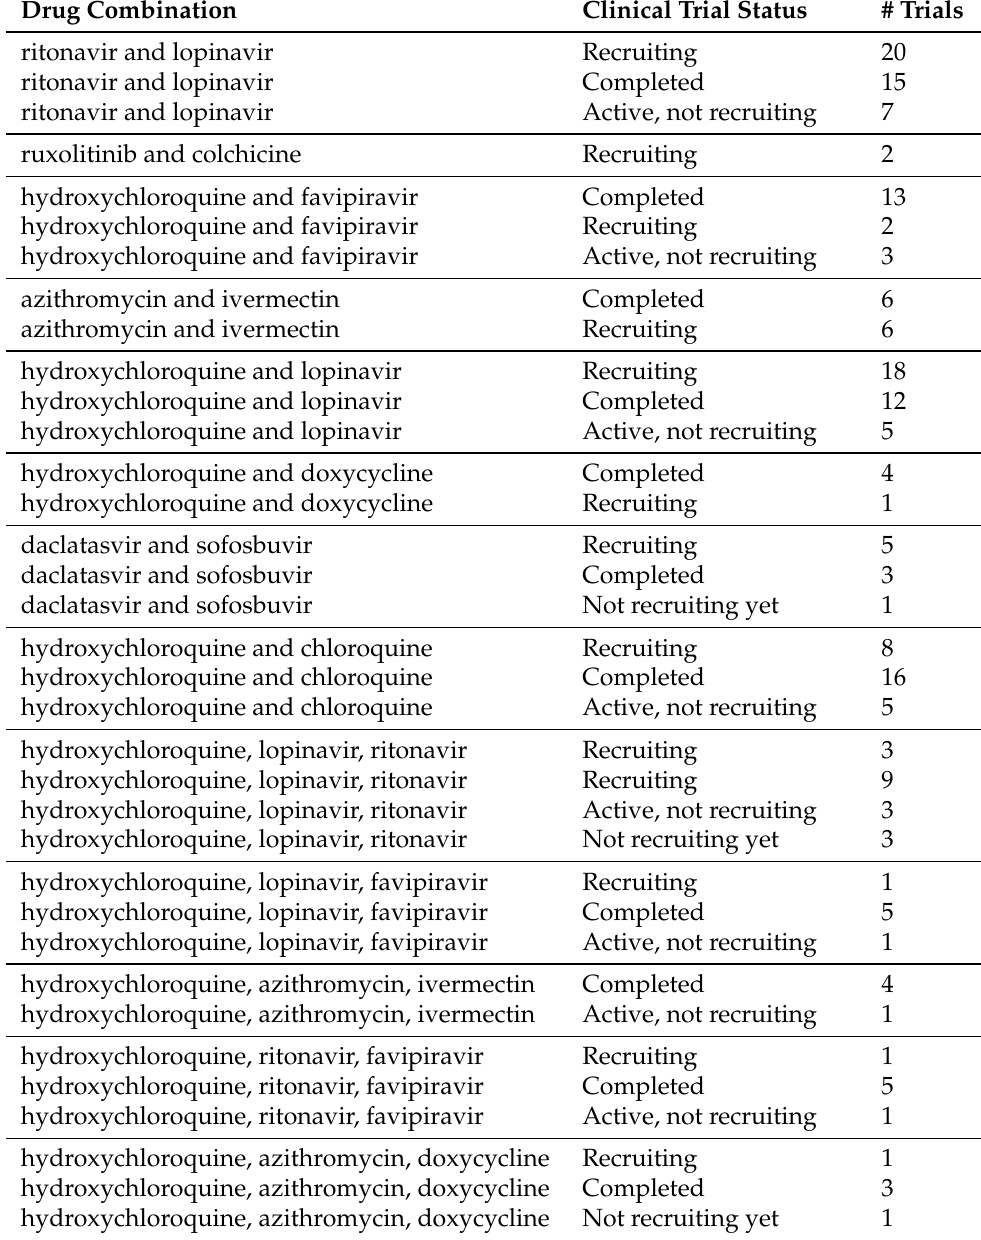
Table 7. Two or three drug combinations in clinical trials that confirm the findings from the biomedical